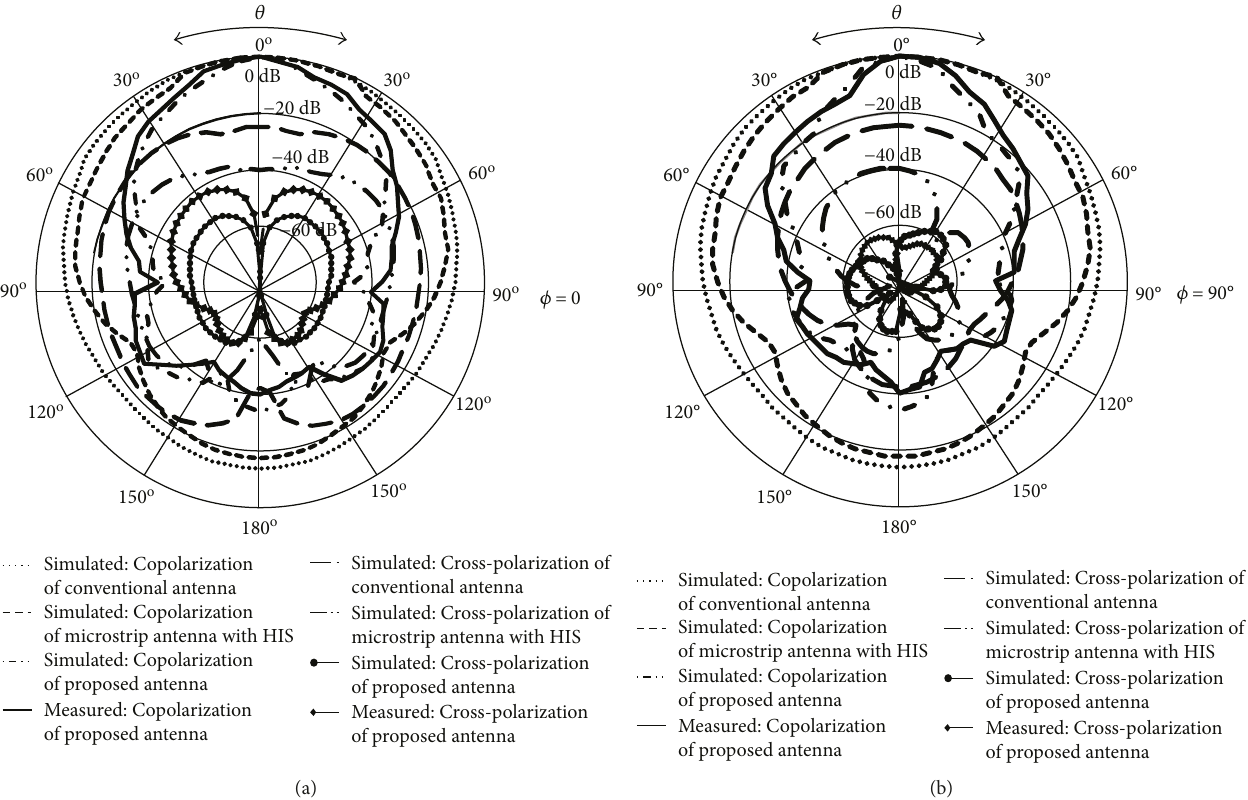
Figure 15: The simulated and measured radiation patterns under various antenna schemes: (a) XZ- and (b) YZ-planes.